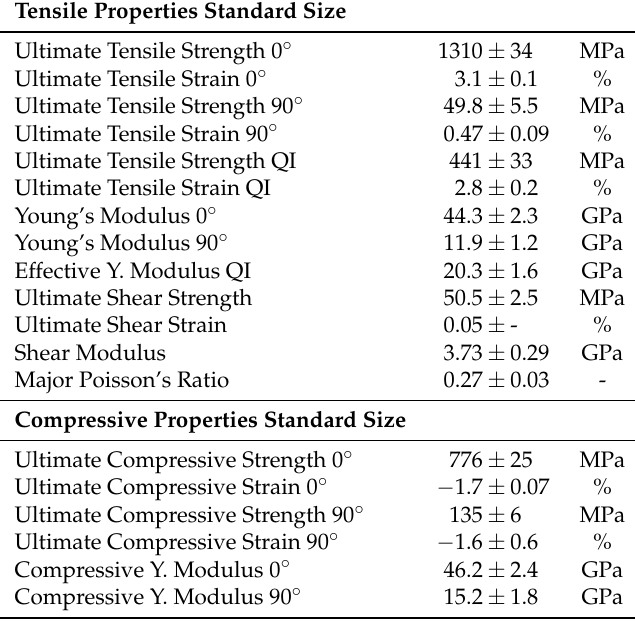
Table 2. Mechanical properties of continuous unidirectional and multidirectional basalt fiber reinforced epoxy laminates. Experiments were conducted based on current standards for testing of fiber reinforced composites as ASTM D 3039 (tension), EN ISO 14126 (compressive) and ISO 14129 (in-plane